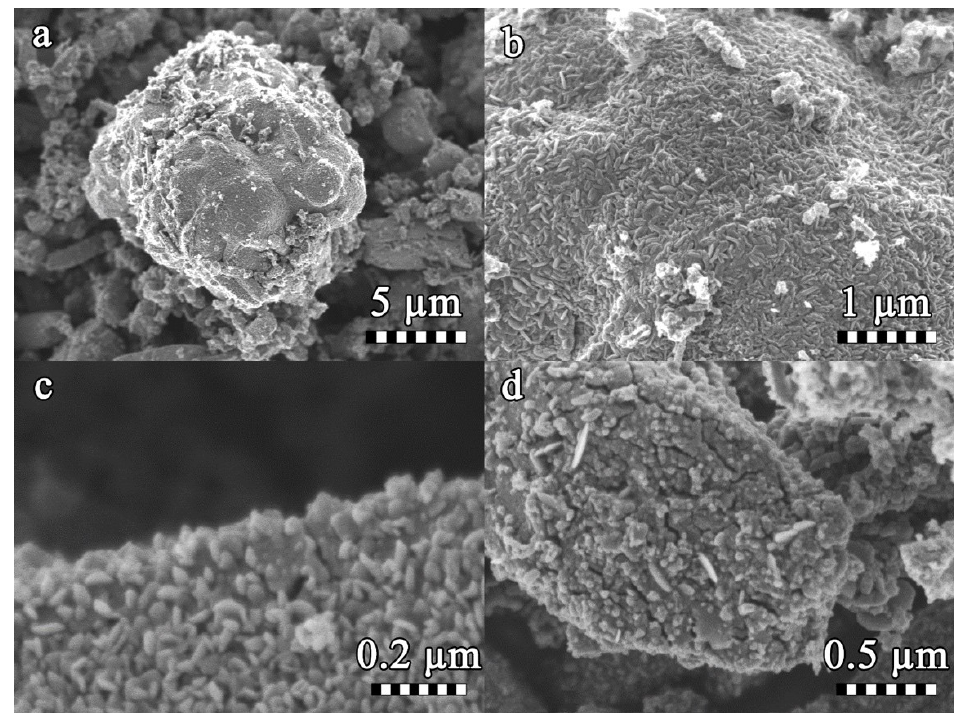
Figure 4. SEM images of sample heat-treated at 595 °C in 100 mL/min 20% N 2 /H 2 flow. Magnification: ( a ) x7200 ( b ) x36000 ( c ) x170000 ( d ) x72000